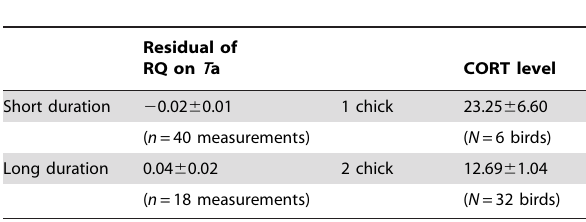
Table 1. The relationships between RQ and the length of fasting endurance, and CORT levels and reproductive success in ancient